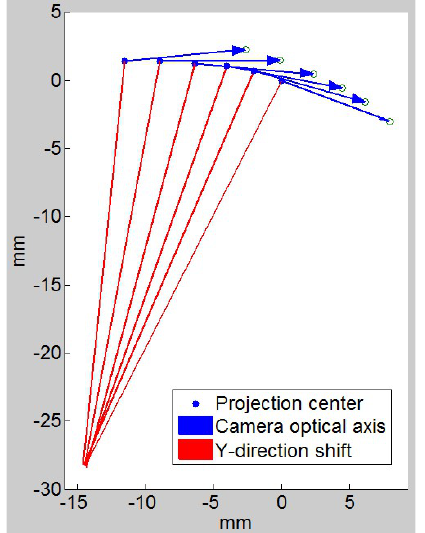
Figure 6. Geometry to determine the X and Z translations for the concentric imaging in the case of the non-motorized mount.